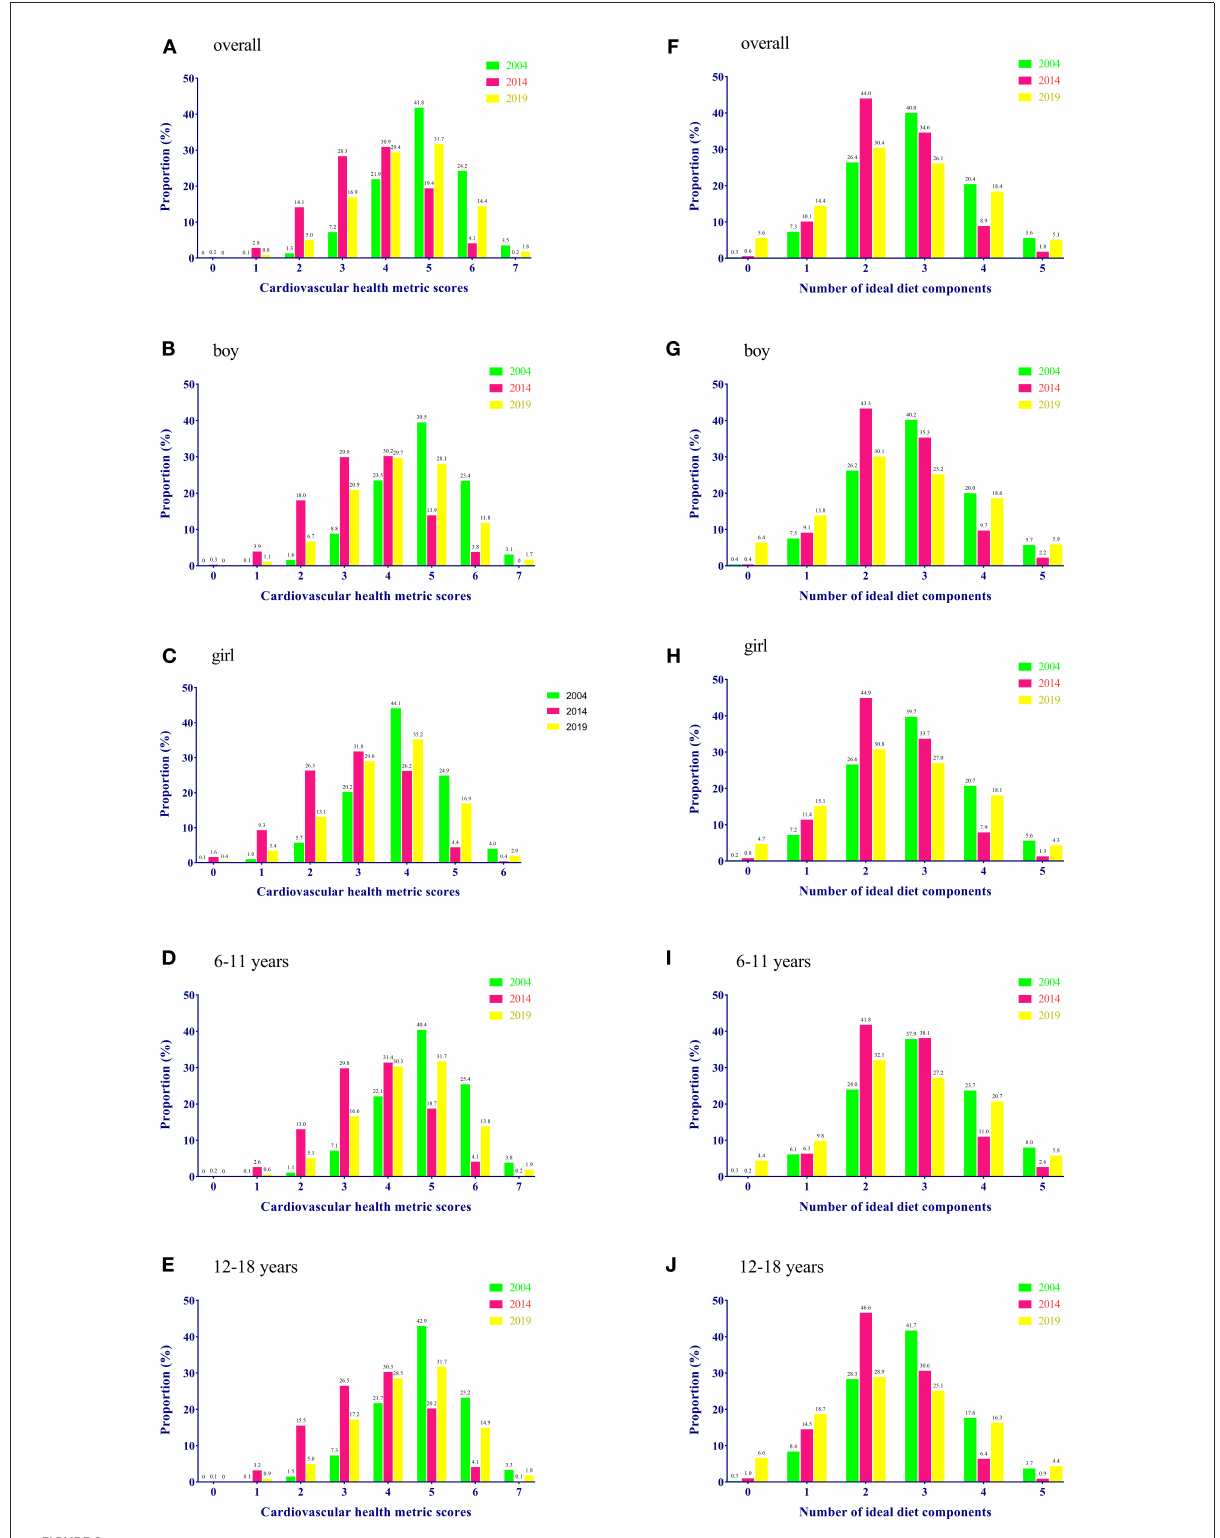
FIGURE2 Distribution of CVH metrics score and healthy diet components in total population and subgroups of sex and age: 2004–2019. (A–E) Stand for the distribution of CVH metrics score in overall population, boys, girls, children aged 6–12 years, and children aged 12–18 years, respectively. (F–J) Stand for the number of ideal diet components in overall population, boys, girls, children aged 6–12 years, and children aged 12–18 years,